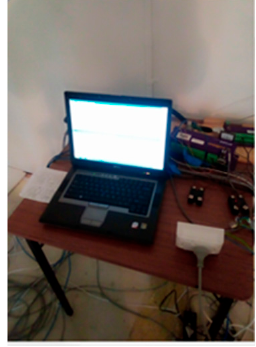
Figure 7. Desk control.